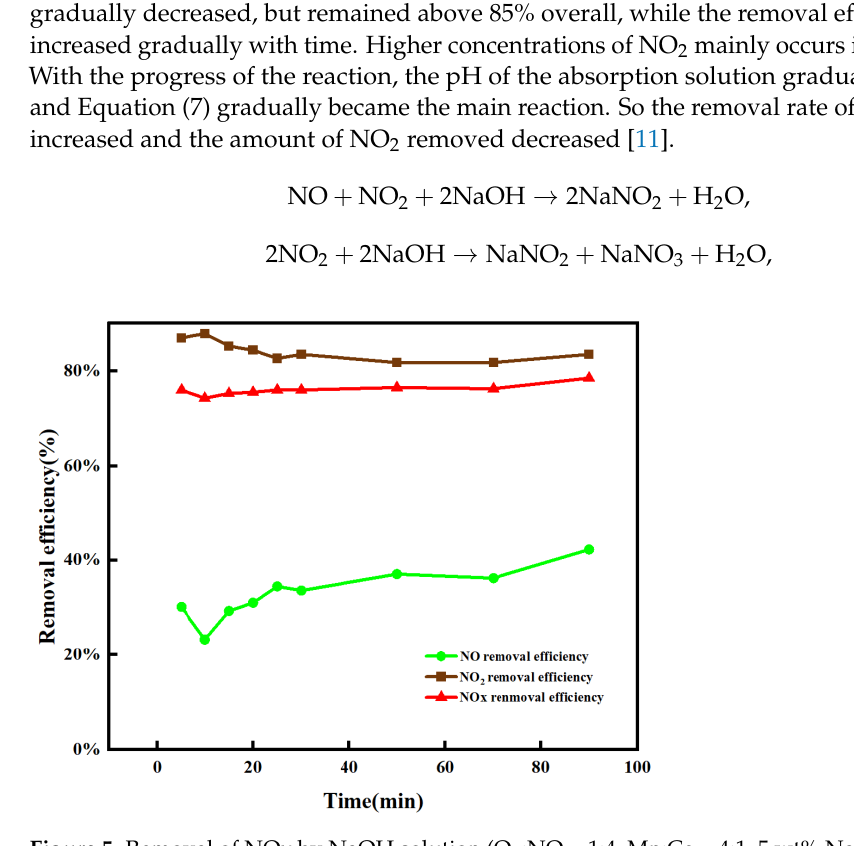
Figure 5. Removal of NOx by NaOH solution (O 3 :NO = 1:4, Mn:Ce = 4:1, 5 wt% NaOH).